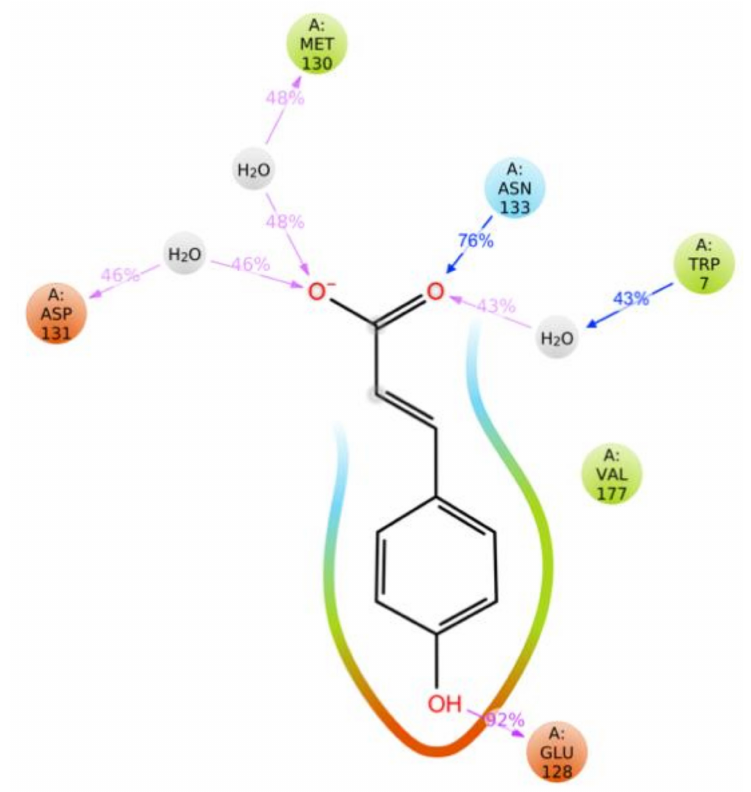
Figure 2. Dynamic interaction of p -CA with amino acids of the MAPK8 active site. Blue arrows indicate the direction of an H-bond donation. Pink arrows indicate H-bond acceptance or salt bridges. The percentages represent the strength of the interaction relative to simulation time. Higher percentages indicate longer interactions during the simulation. This image was obtained from the molecular dynamics simulation report that was produced by Desmond